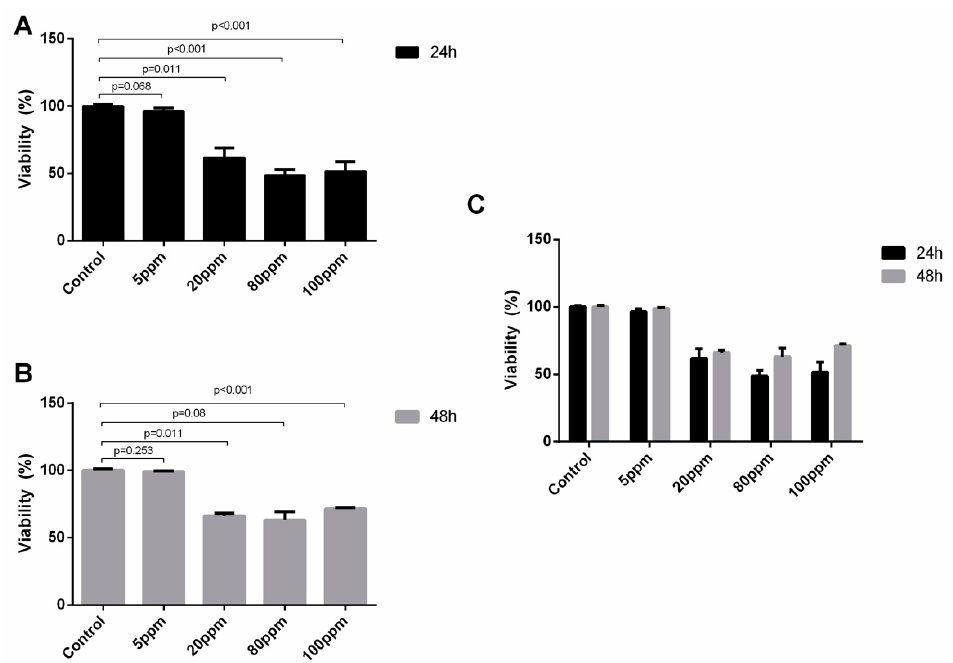
Figure 5. PC-3 cells viability assessed by trypan blue exclusion method upon treatment with AgNPs for 24 h ( A ) and 48 h ( B ) and the comparison between their effect at the two time points ( C ). Results are expressed as percentage of control (untreated cells), as mean ± SEM.